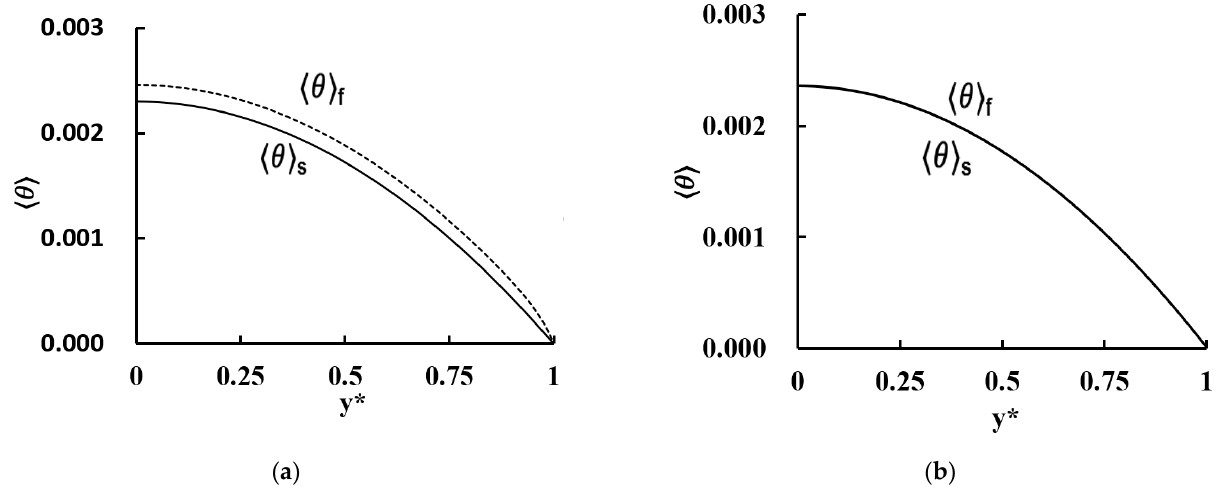
Figure 7. Dimensionless temperature profiles of solid and fluid phase for LHC when Re 𝐻 = 2000 ( a ) 5 PPI, ( b ) 40 PPI.